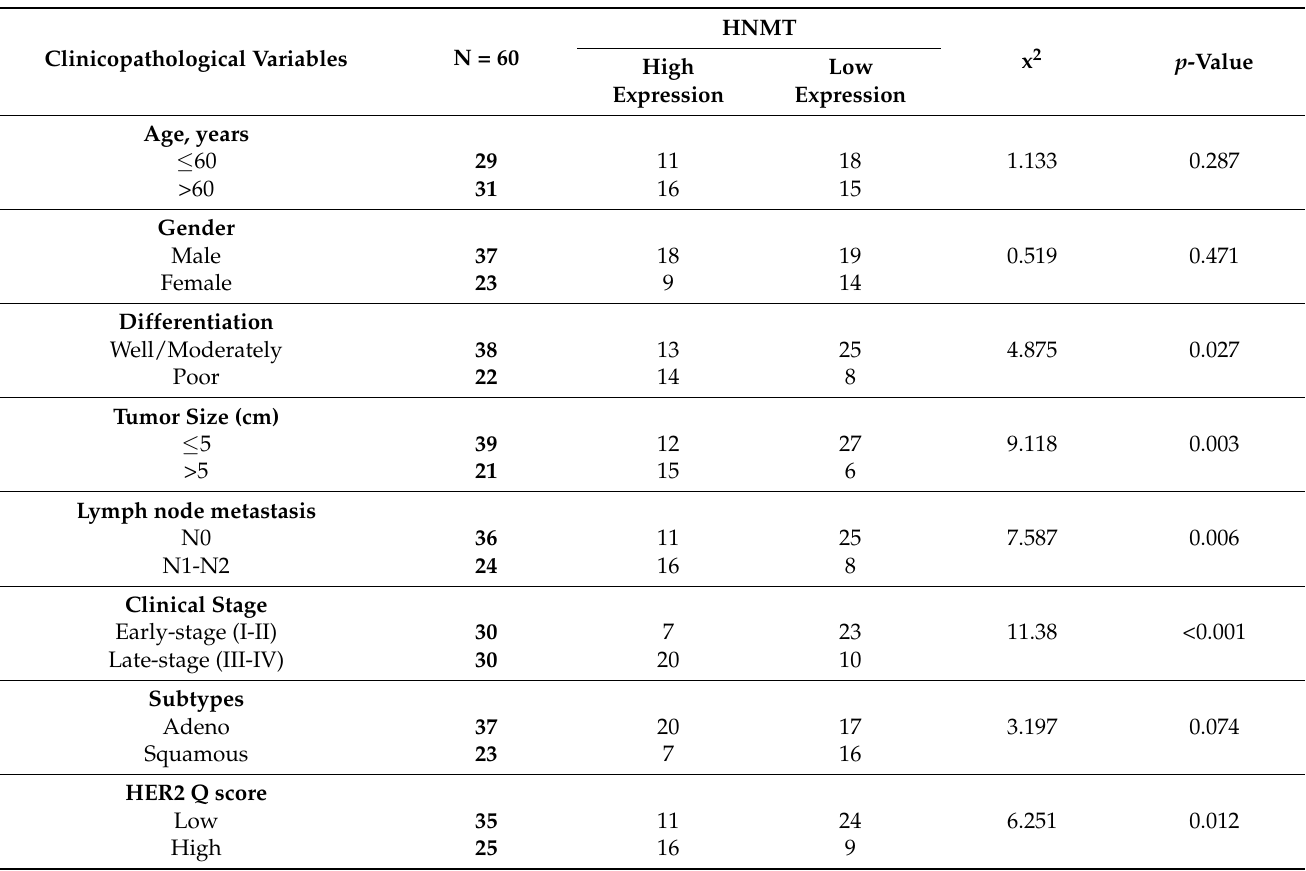
Table 1. The summary of clinicopathological features and distribution of HNMT status in 60 patients with NSCLC patients.